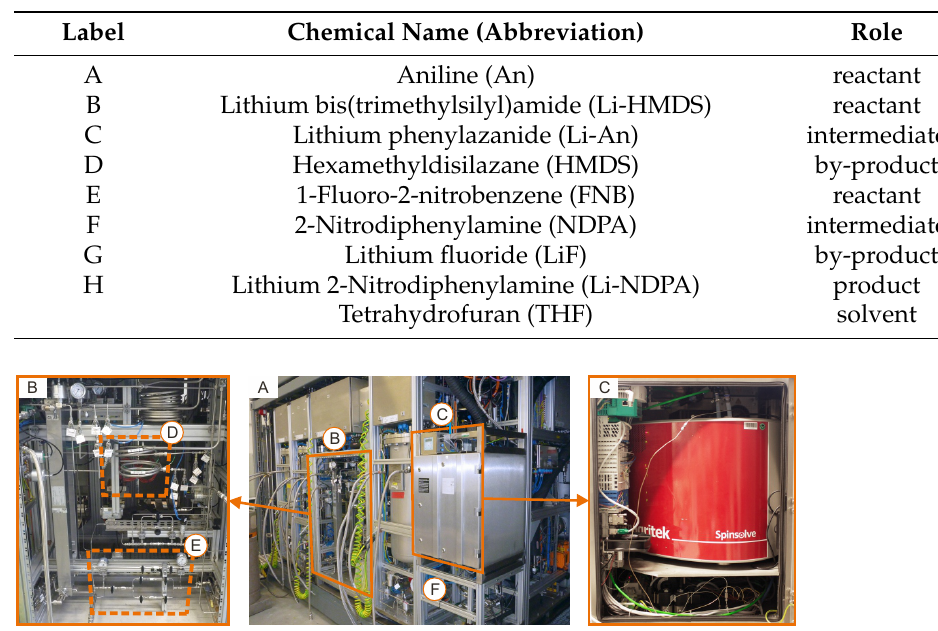
Figure 10. ( A ) picture of modular pilot plant for continuous production of Li-NDPA. ( B ) close-up of tubular reactor (D, inner diameter = 12.4mm) and filter section (E). ( C ) picture of integrated compact NMR spectrometer (43MHz) with ATEX certified pressurized housing for online concentration measurements. (F) indicates location of the NIR flow